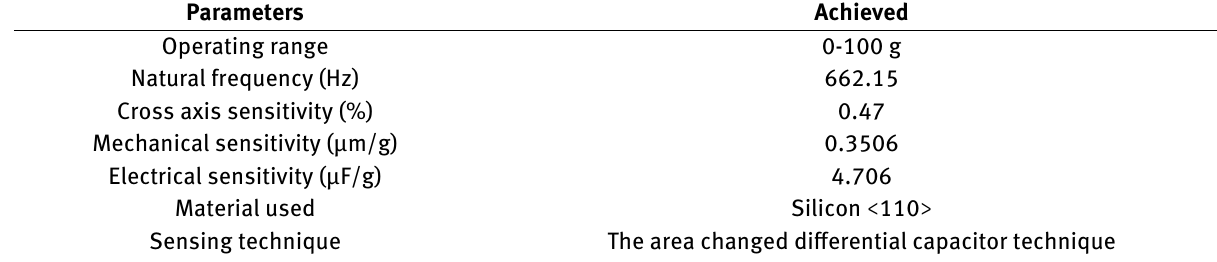
Table 4: Output parameters of designed micro accelerometer